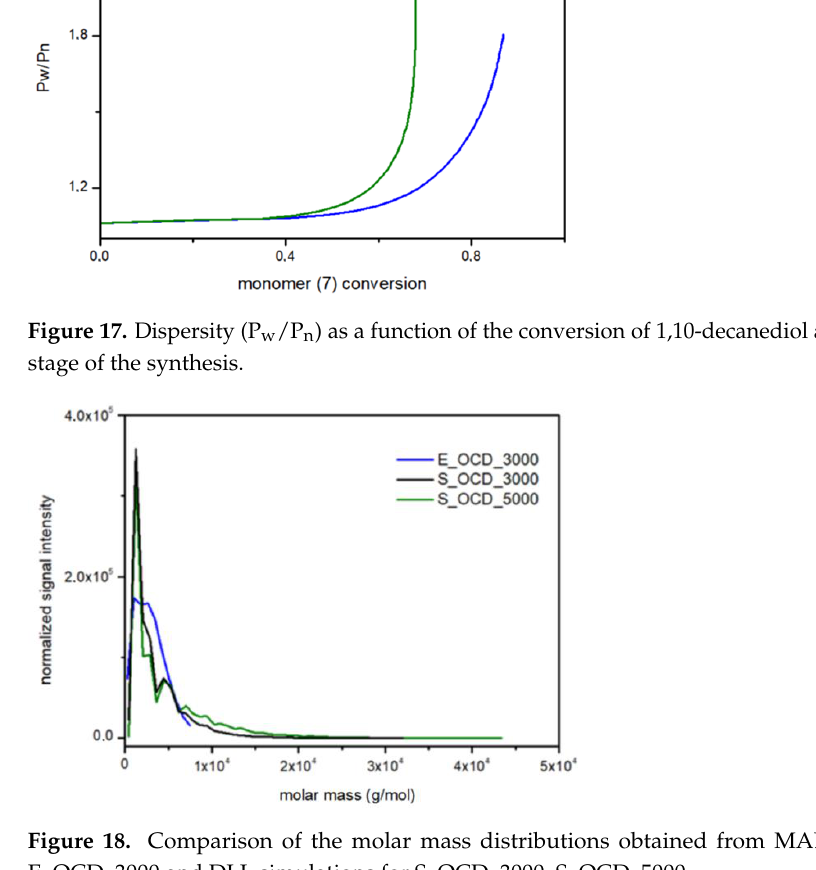
Figure 18. Comparison of the molar mass distributions obtained from MALDI-TOF traces for E_OCD_3000 and DLL simulations for S_OCD_3000, S_OCD_5000.